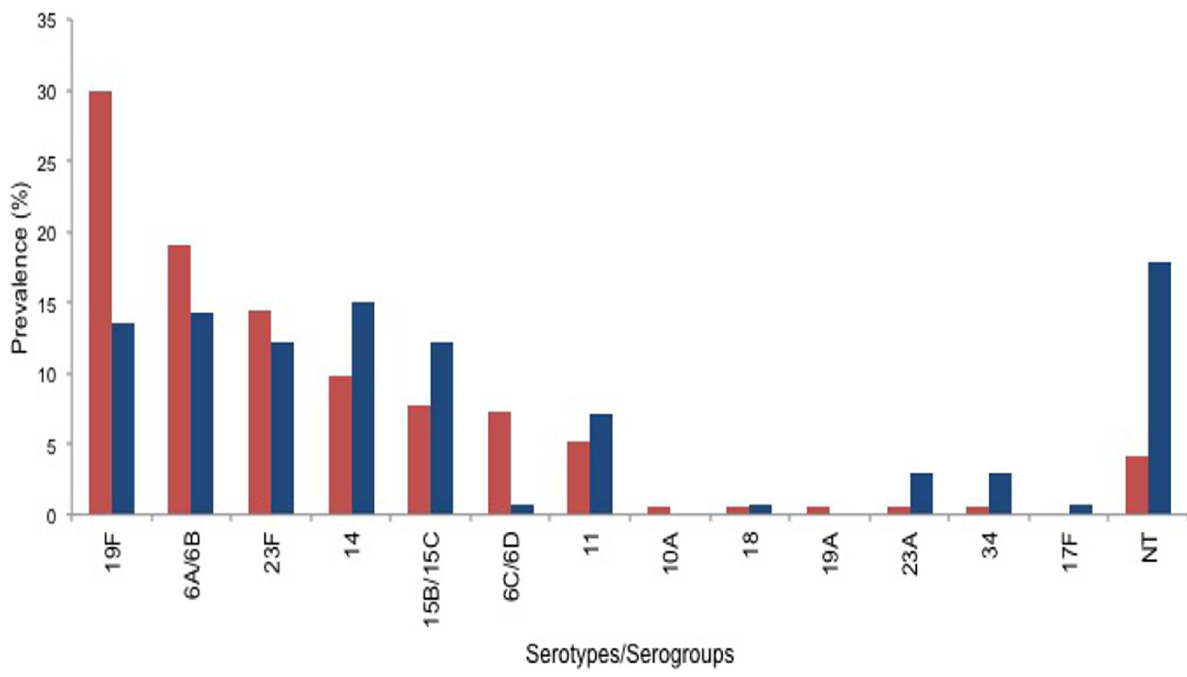
Figure 2. Distribution of serotypes/serogroups of pneumococcus in ARI cases and healthy children. Thirteen different serotypes/ serogroups were detected; DNA samples which were positive for lytA (pneumococcus positive), but negative for tested 29 serotypes/serogroups were assigned as non-typeable (NT). Prevalence of each serotype/serogroup was calculated as proportion of total number of a serotype/serogroup to the total number of the lytA positive samples. Serotype/serogroup of ARI cases and healthy children were plotted in red and blue respectively. Proportion of serotype/serogroup covered by 13-valent conjugated vaccine (PCV13) was 74% in ARI cases and 55% in healthy children.